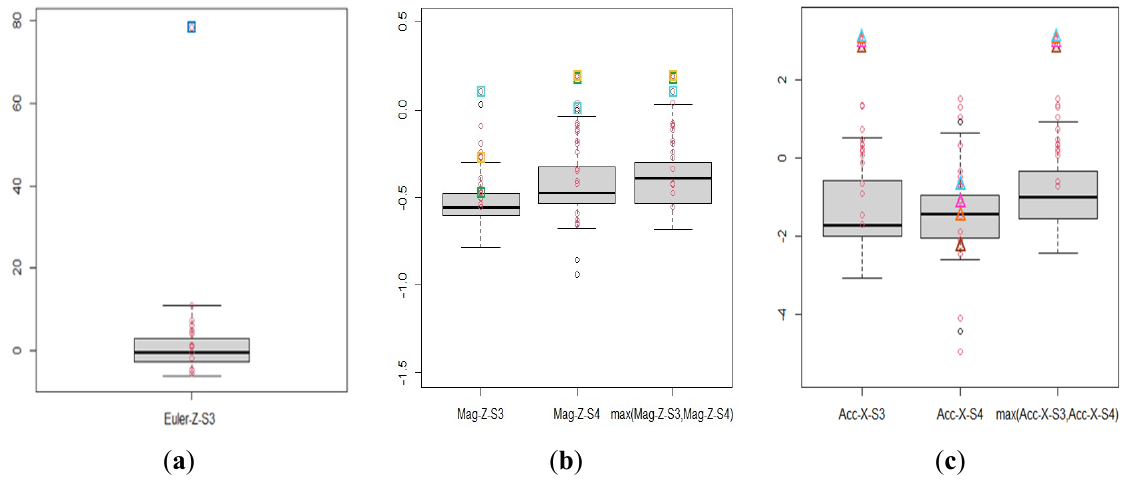
Figure 7. Boxplots of the filtered variables, ( a ) Euler − Z − S3, ( b ) max(Mag − Z − S3, Mag − Z − S4), and ( c ) max(Acc − X − S3, Acc − X − S4), for PC observations at N 6 , where the values in the y − axis are computed from (1) using corresponding variables, the red circles denote the corresponding HD observations and those in color boxes or triangular are the detected extremely aberrant HD observations. In addition, the boxes (or triangular) in the same color are the observations of the same